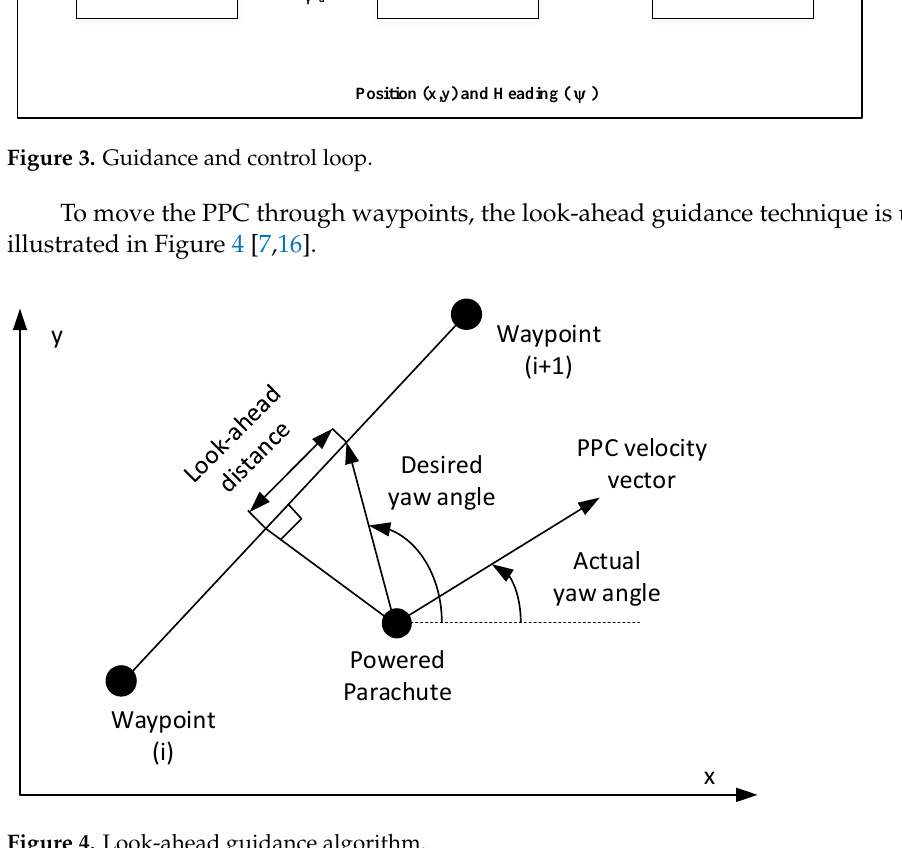
Figure 5. Structure of the PPC lateral FLC. Selecting the number and distribution of membership functions (MFs) for the inputs and outputs comprises the first steps in the FLC design. Seven normalized membership functions with triangular shapes were studied in this paper; see Figure 6 [8]. To describe these functions, the location of the vertices of the triangles must be determined. Only two parameters (a 1 and a 2 ) are needed for each variable. To transform the normalized ranges of the MFs into physical operating ranges, the following scaling factors are used: